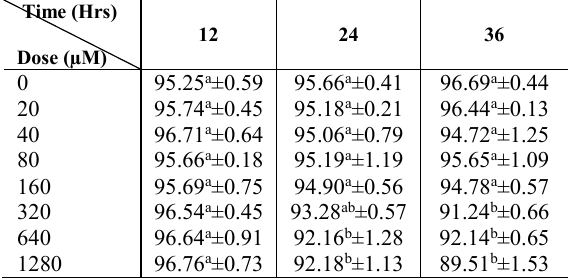
Table 1. Mean percentage of BMSCs viability after 12, 24, and 36 hours of treatment with various